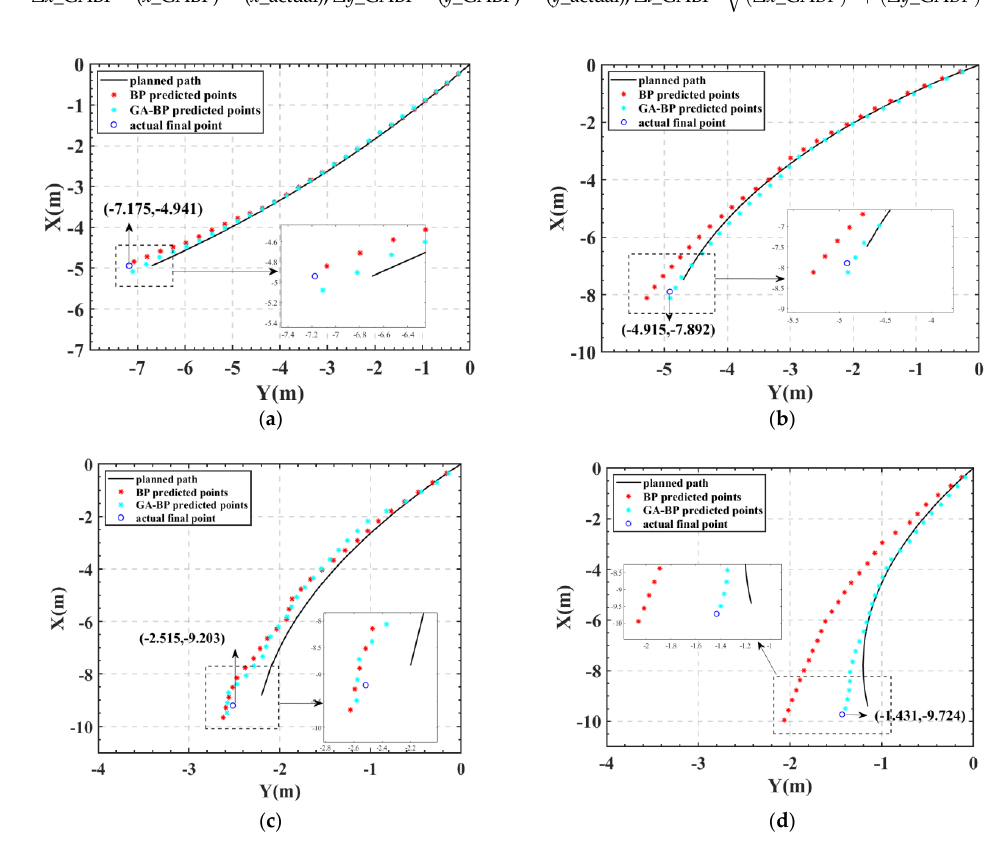
( e ) Figure 14. On-orbit planning path and predicted path from sol.27 – sol.36: ( a ) sol. 27; ( b ) sol. 28; ( c ) sol. 29; ( d ) sol. 34; ( e ) sol. 36.